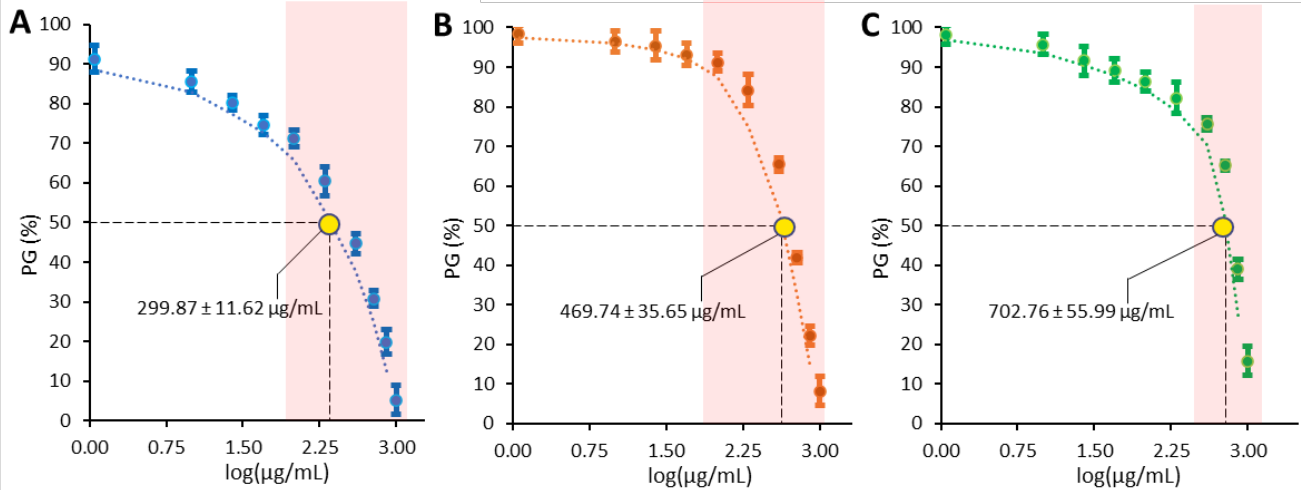
Figure 2. Antiproliferative activity exerted by the WRSP extract on ( A ) HepG2, ( B ) MCF-7, and ( C ) HeLa cell line. Dose/response curves are shown as percent growth (PG%) versus concentration expressed as Log( µ g DW/mL cell medium). The bars reported near the coloured dots represent the standard deviation of each measurement at the relative concentration. The yellow dot reports the GI 50 (µg DW/mL cell medium) of WRSP on each cell line. The red box represents the linear portion of inhibition curve within which the GI 50 value was determined.